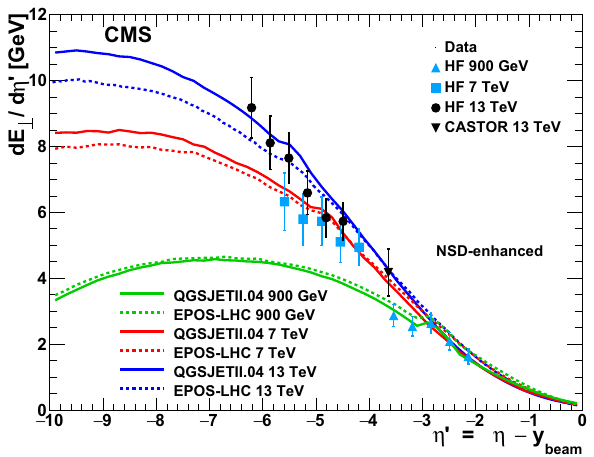
Fig. 4 A comparison of the measurements of the transverse energy √ s = 13TeV,asafunctionofshiftedpseudorapid- density,d E T / d η (cid:5) ,at ity, η (cid:5) = η − y beam , to the predictions and to earlier proton–proton data [6] for an NSD-enhanced selected sample at several different centre-of- mass energies. The error bars indicate the total systematic uncertainties. √ s of 13, 7 and The beam rapidities y beam are about 9.5, 8.9, and 6.8 at 0.9TeV,